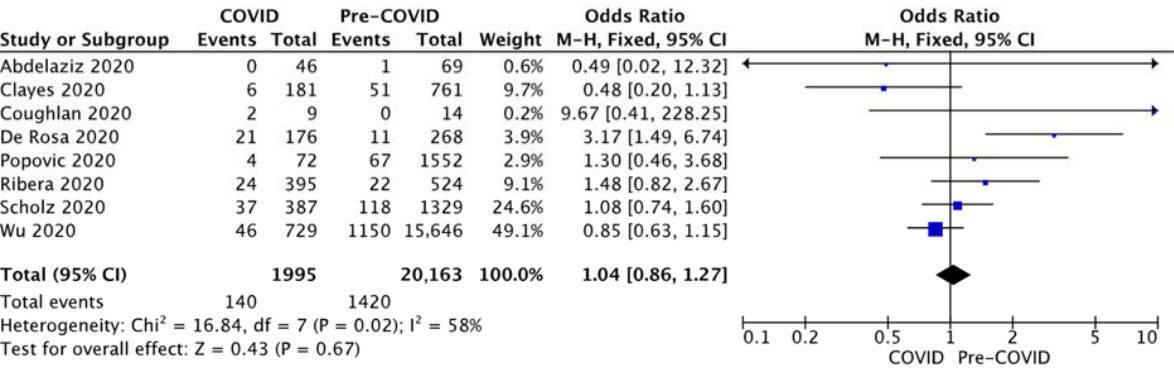
Figure 9. Forest plots for In-hospital mortality.